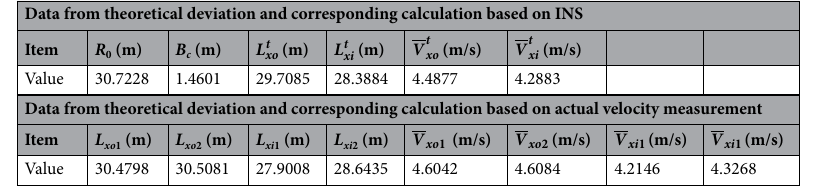
Table 3. Calculation results of the